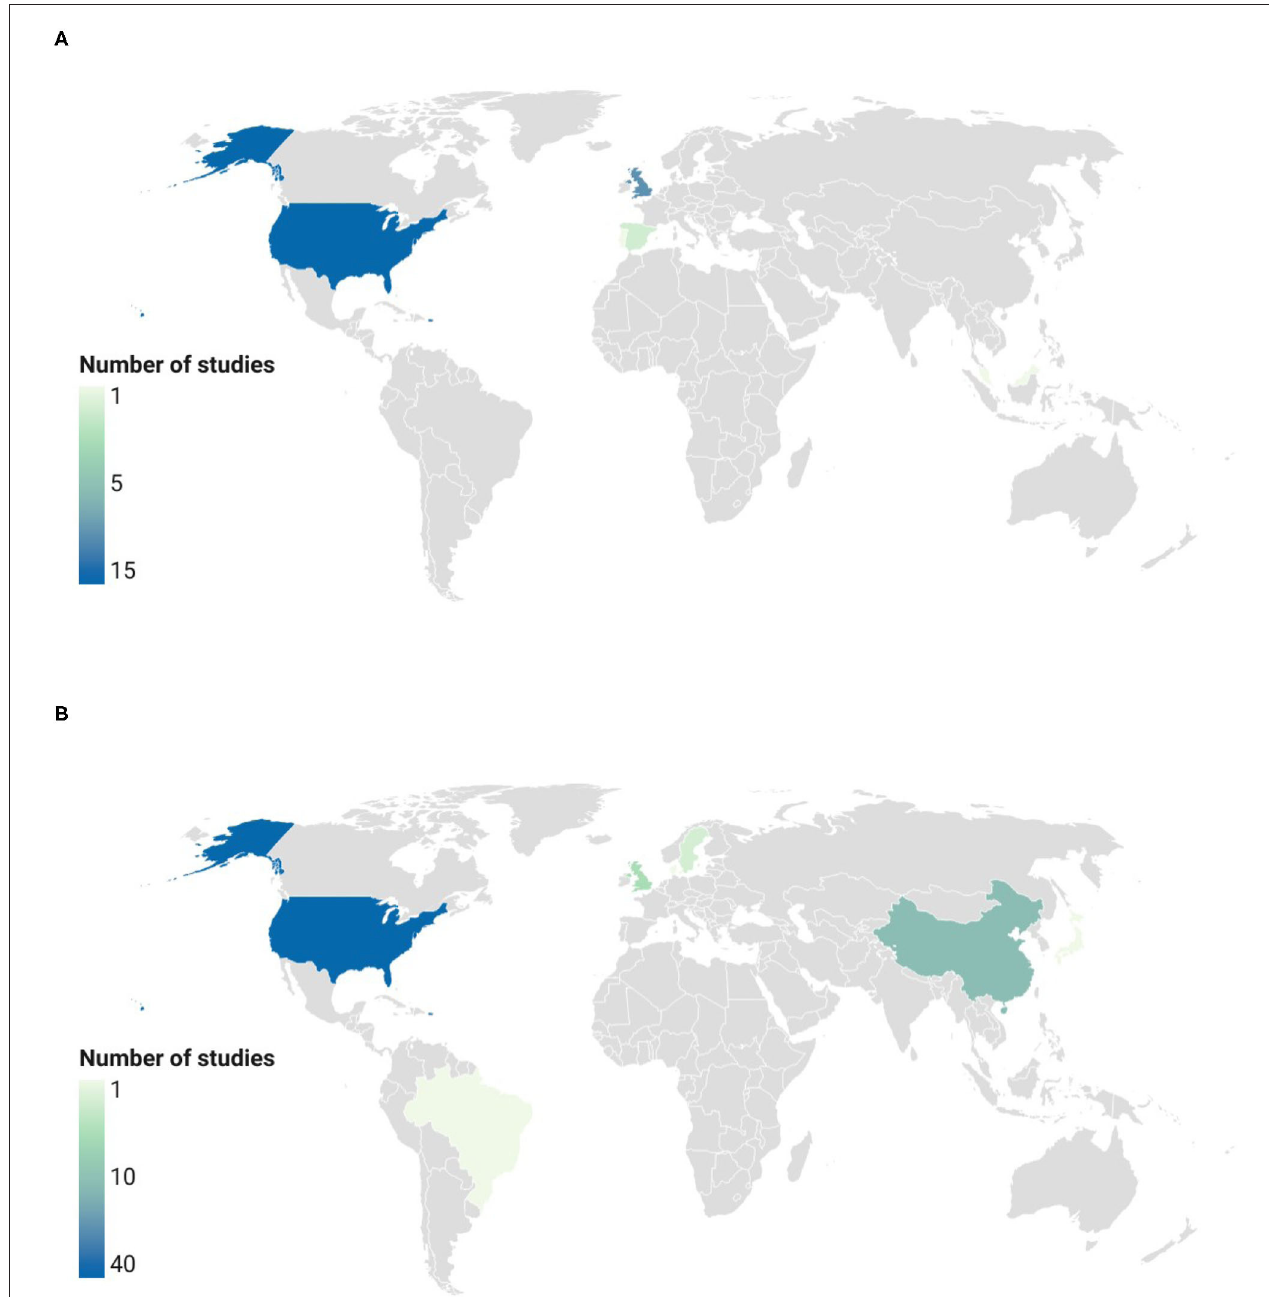
FIGURE 9 | Countries with the highest number of registered studies on GSL-rich foods (A) and extracts (B) . “Low”: < 5 registered trials; “medium”: 5–10 registered trials; “high”: > 10 registered trials. Locations not reporting clinical trials on GSLs are colored in